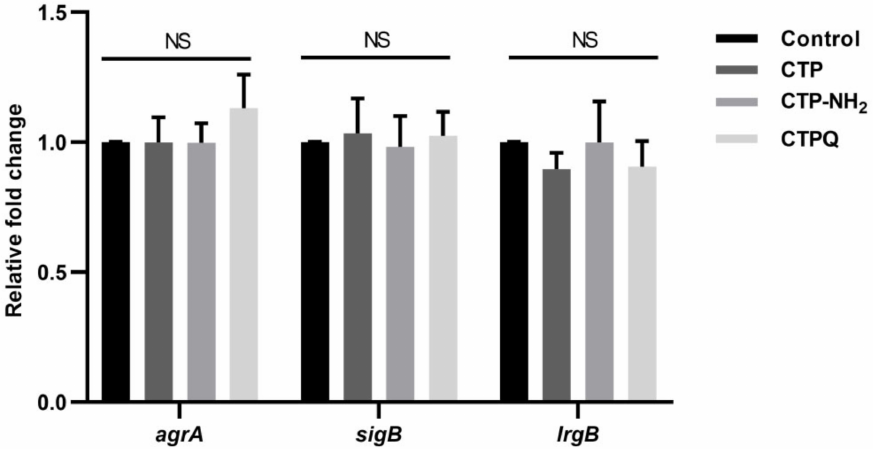
Figure 12. The qRT-PCR results of S. aureus ATCC 43300 genes related to biofilm treated with CTPs. NS: not significant ( p > 0.05) ( n =